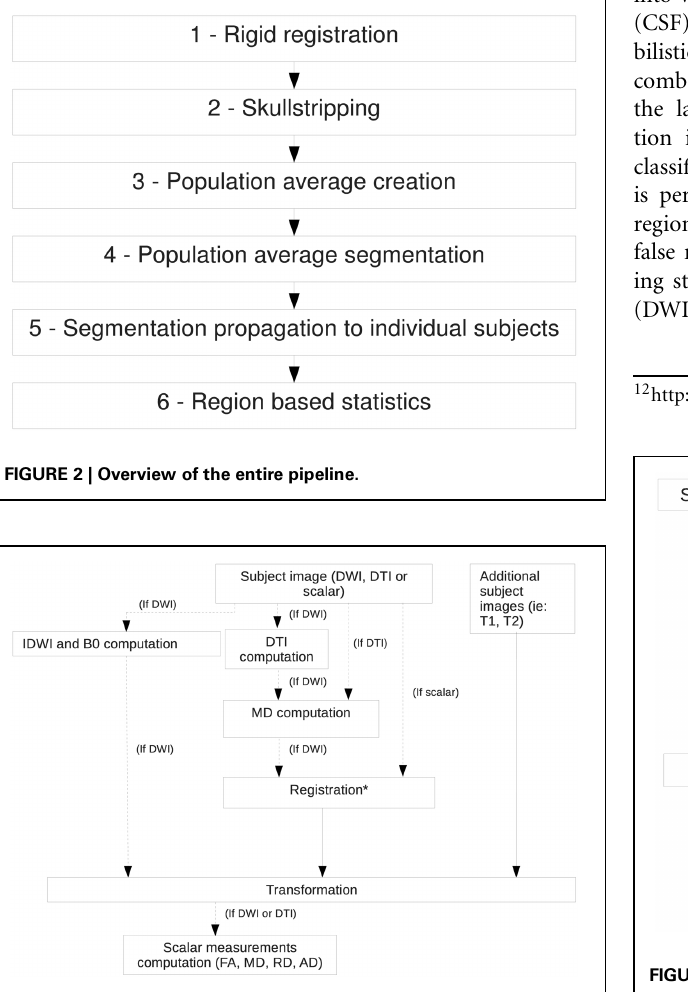
FIGURE 3 | Rigid registration pipeline. Registration is performed using RegisterImages, a tool distributed with 3D Slicer.